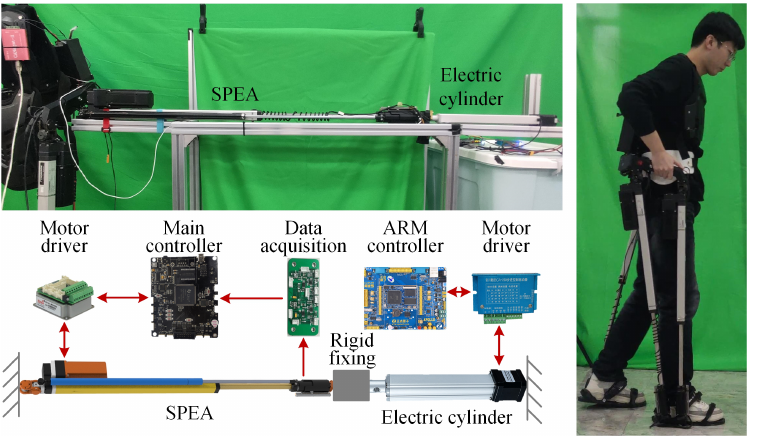
Figure 10. Experimental conditions.